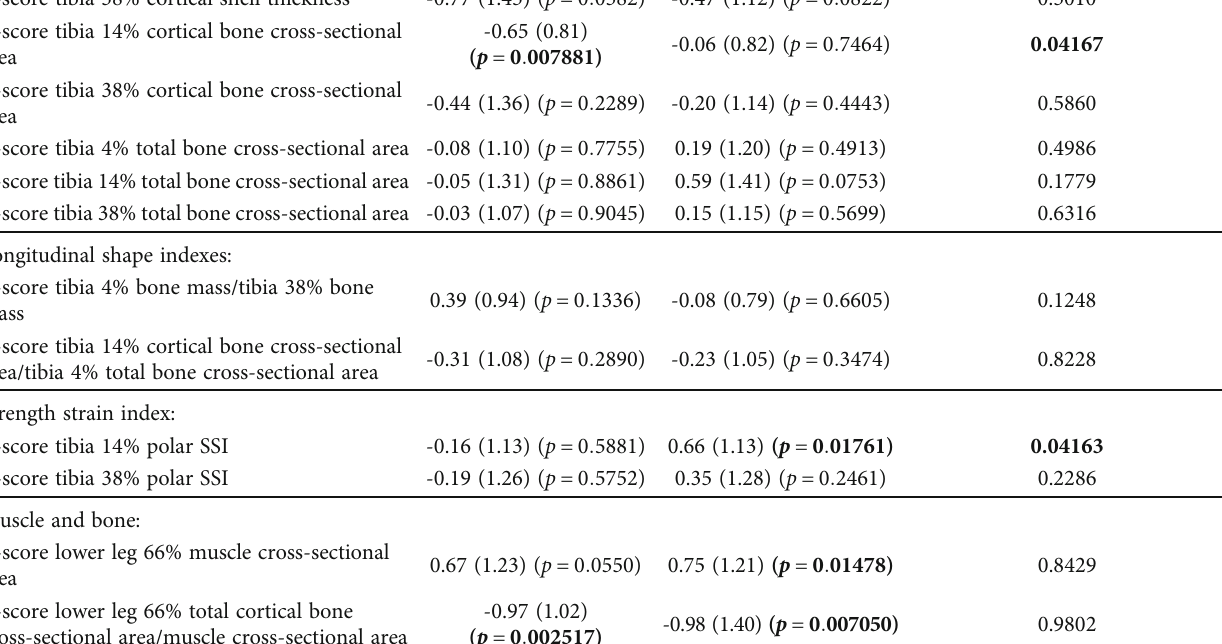
Male ( n = 20 ) Female ( n = 15 ) Mean (SD) Mean (SD) p value (di ff . from 0) p value (di ff . from 0)